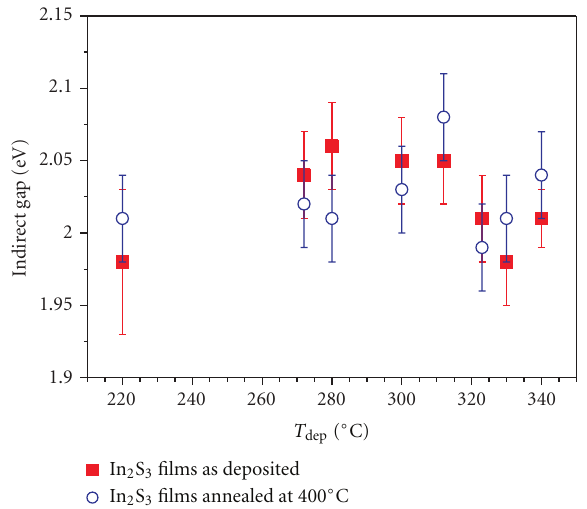
Figure 1: Energy of the indirect gap extrapolated from optical conductivity measurements (1) on In 2 S 3 films on glass, as deposited (red open squares) and after annealing in the furnace at 400 ◦ C (blue open circles).